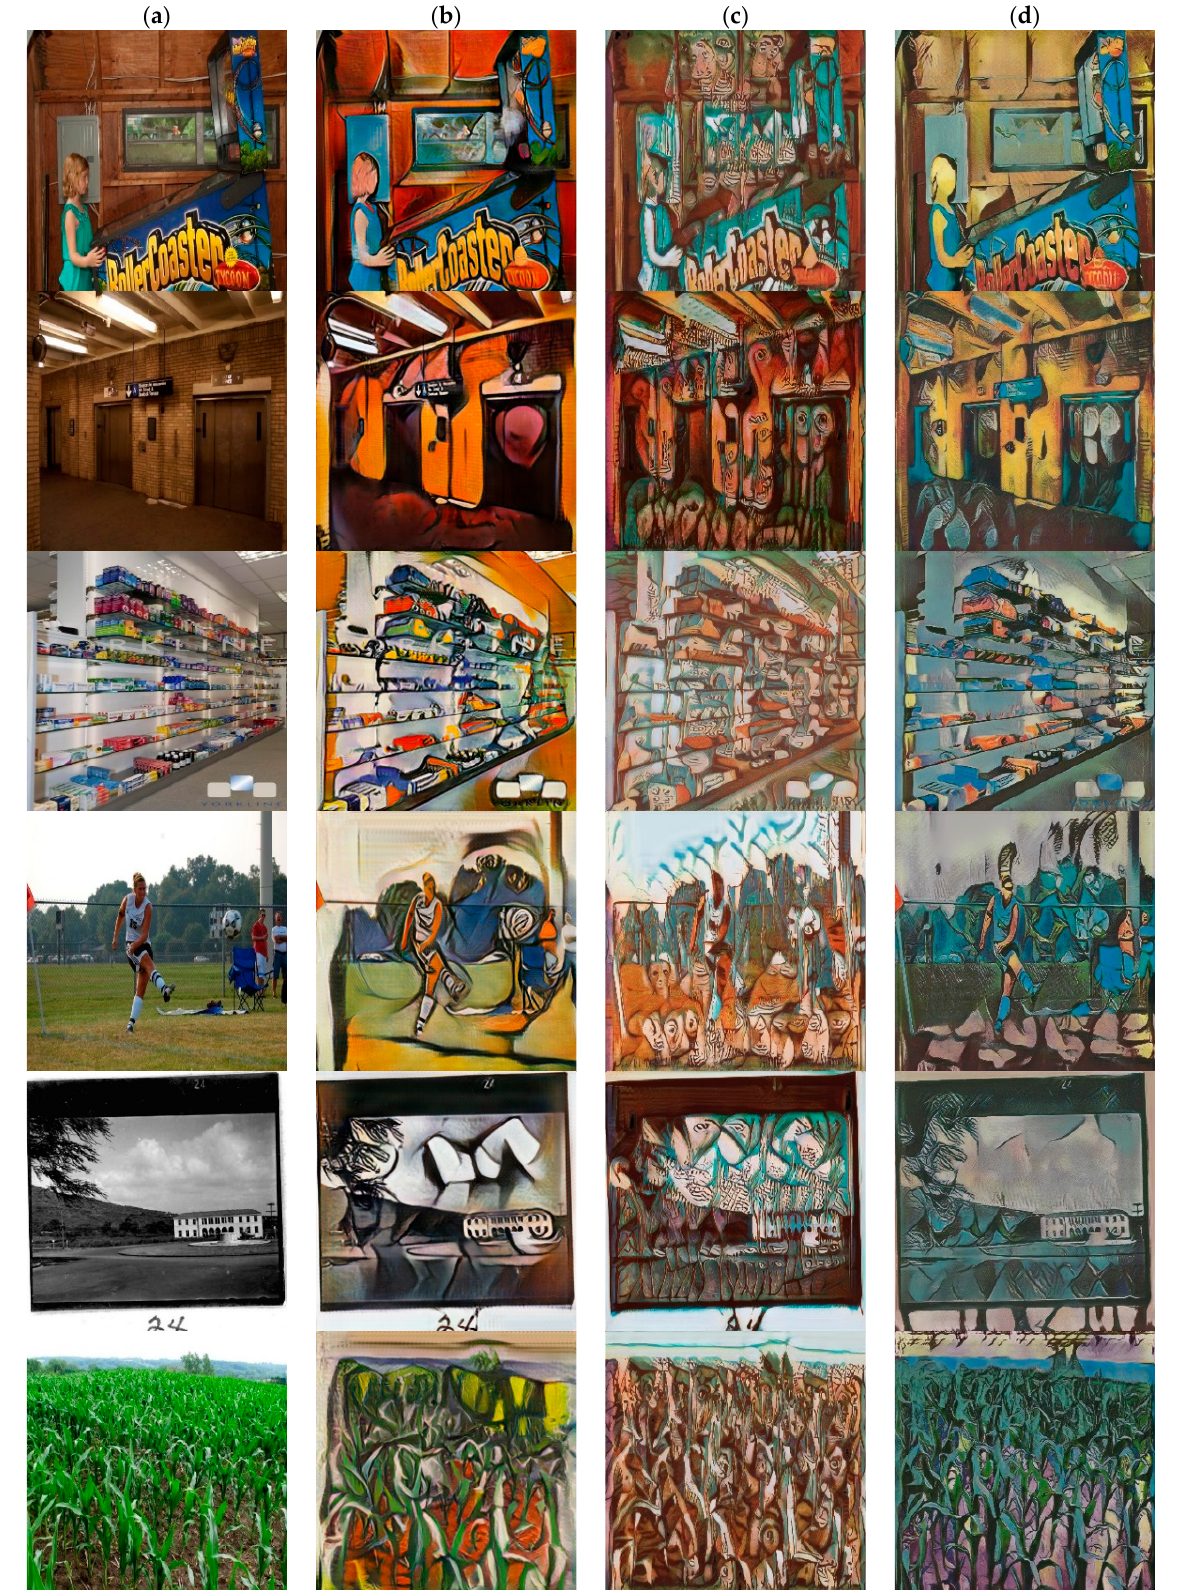
Figure 6. Comparison with different style transfer method based on the Picasso style collection. ( a ) Inputs. ( b ) CycleGAN [13]. ( c ) Sanakoyeu et al. [12]. ( d ) Ours.